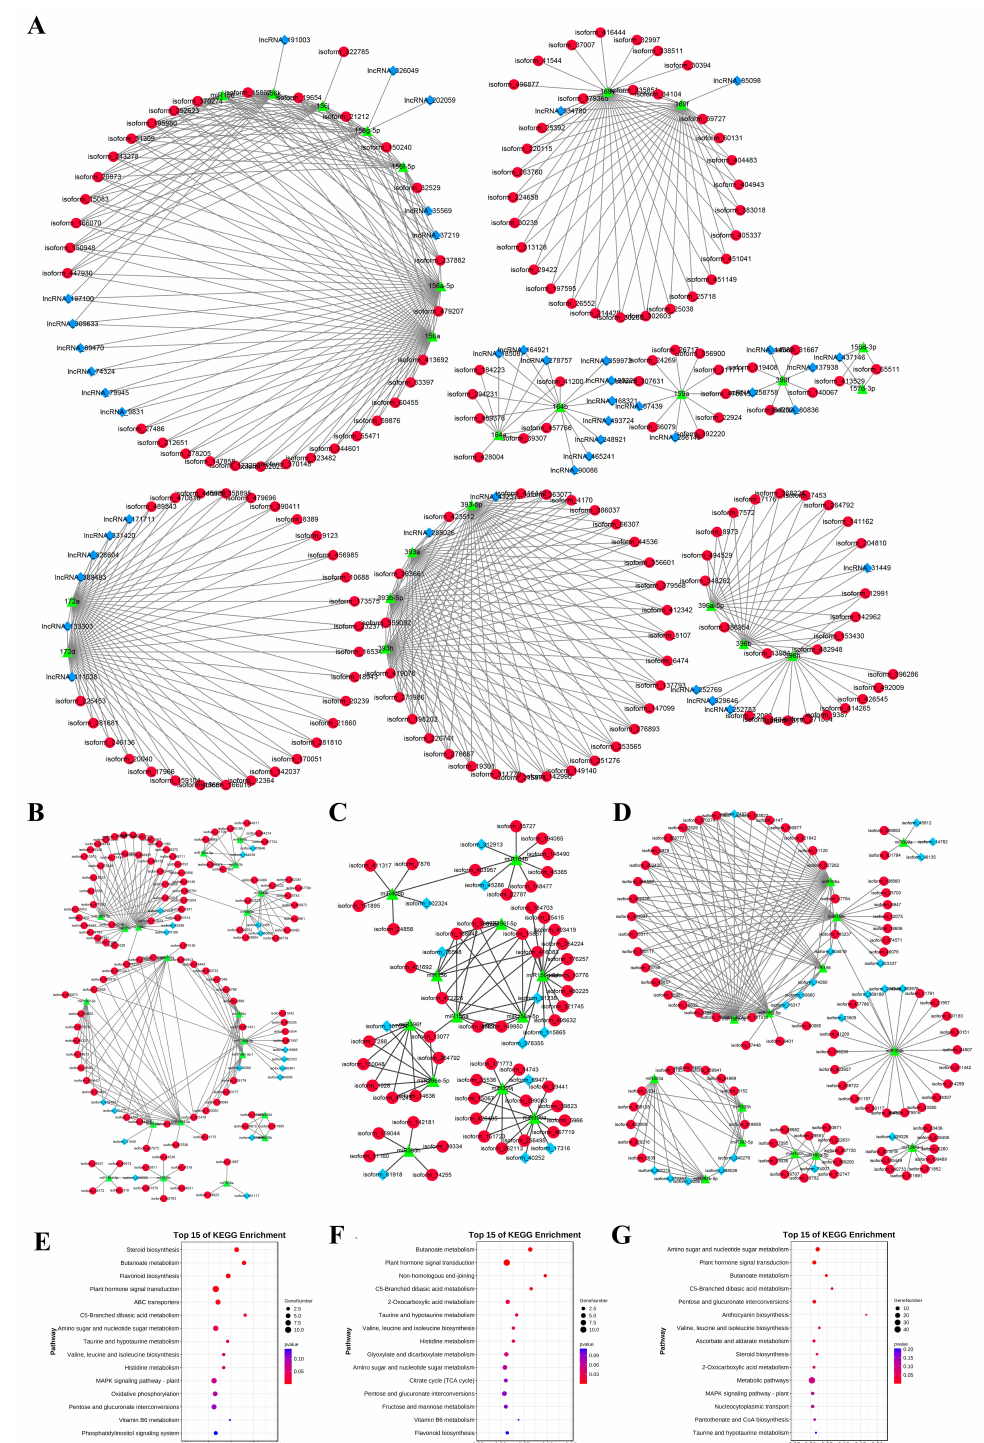
Figure 9. Construction of ceRNA network during garlic somatic embryogenesis. ceRNA Network during Somatic embryogenesis (some important nodes) ( A ); DE lncRNA–DE miRNA–DE mRNA networks of EX-VS-CA, CA-VS-EC, and EC-VS-GE stages, respectively ( B – D ); KEGG analysis of DE mRNA at EX-VS-CA, CA-VS-EC, and EC-VS-GE stages, respectively ( E – G ). Note: the blue diamond is lncRNA; the red circle is mRNA; the green triangle is